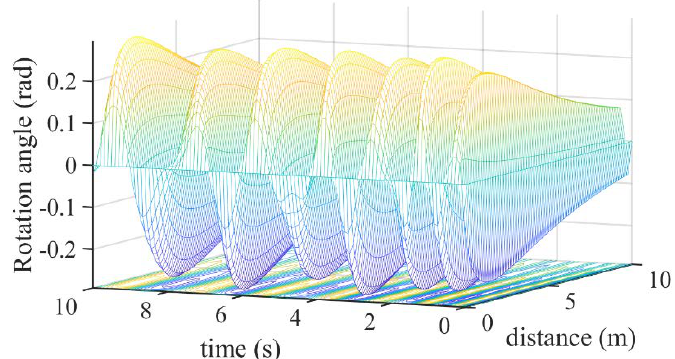
Figure 7. Change of rotation angle of shock wave with time and distance.